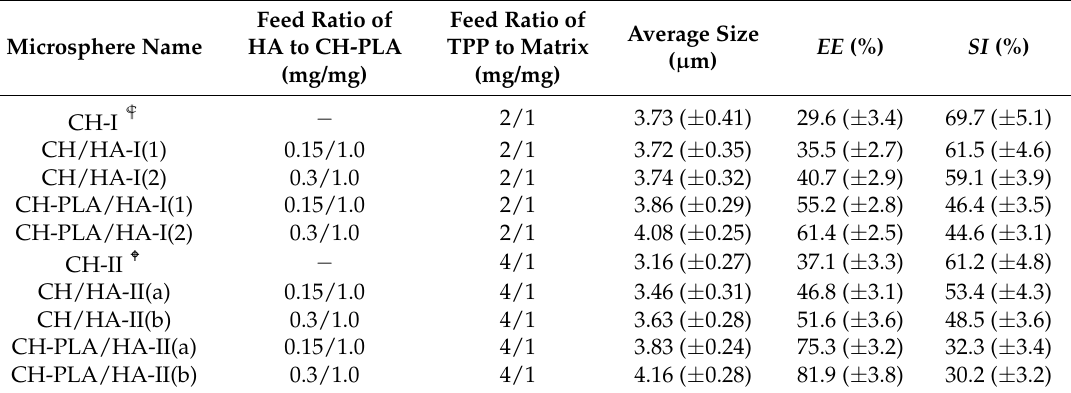
Table 2. Parameters of TGF- β 1-loaded microspheres ( n = 4) (†) .